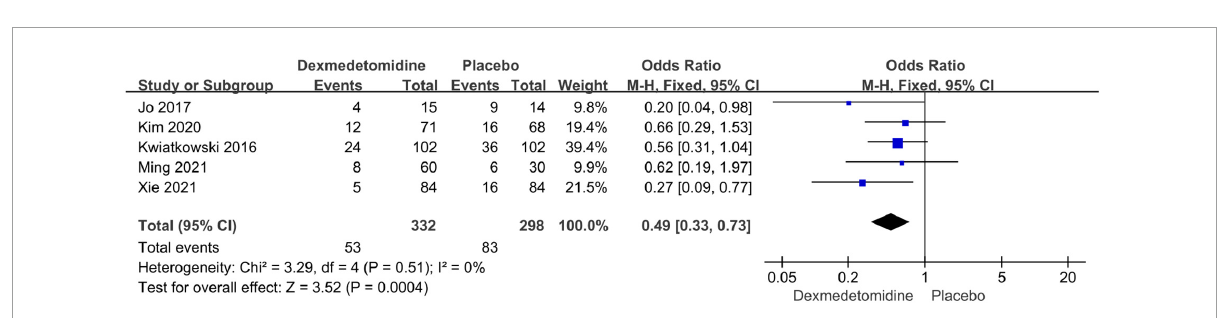
FIGURE3 Pooled result of the incidence of AKI in pediatric patients undergoing cardiac surgery between dexmedetomidine and placebo.